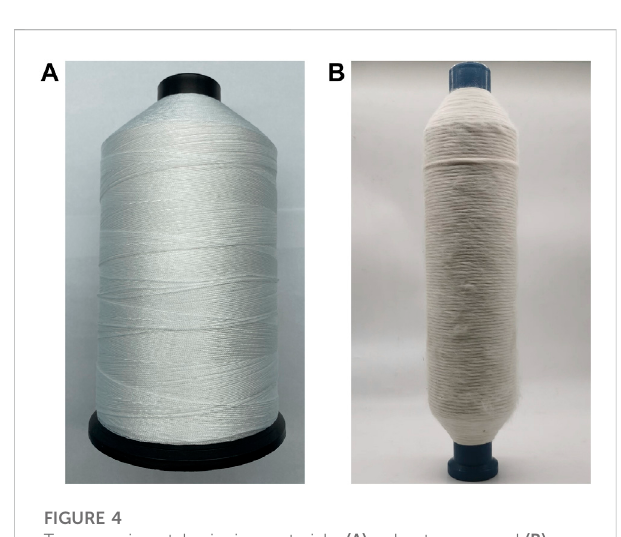
FIGURE 4 Two experimental spinning materials: (A) polyester yarn and (B) cotton fi